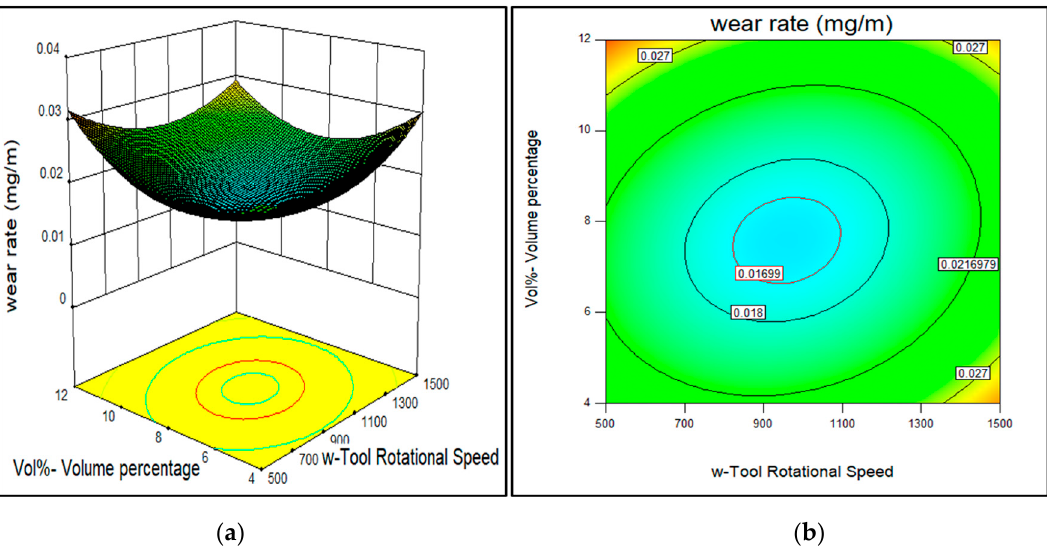
Figure 7. Effect of tool rotational speed and reinforcement volume percentage on the wear rate of AA7075-SiC/fly ash composites ( a ) 3D surface and ( b ) contour plot.